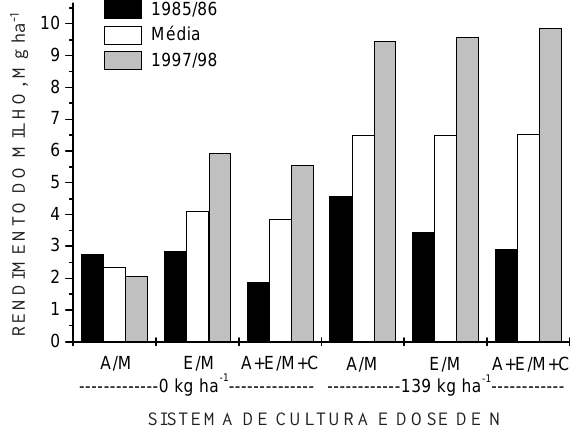
Figura 2. Rendimento de grãos de milho nos sistemas de culturas, em duas doses de N mineral. Médias de três sistemas de preparo de solo. A = aveia, M = milho, E = ervilhaca, C =